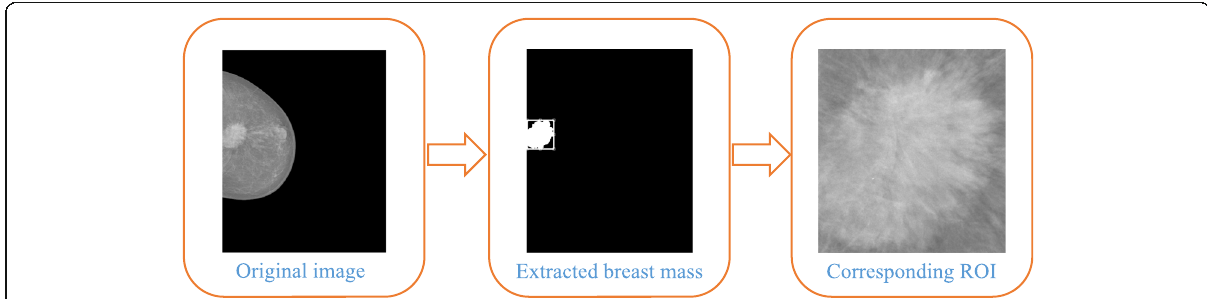
Fig. 3 Snapshots for describing the steps used in the extraction of mass